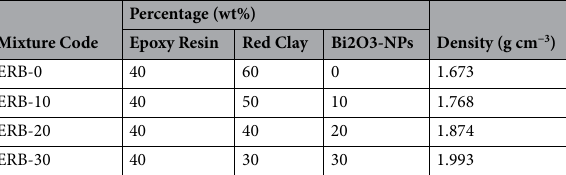
Table 2. Chemical compositions of Epoxy resin –Red clay- Bi 2 O 3 NPs